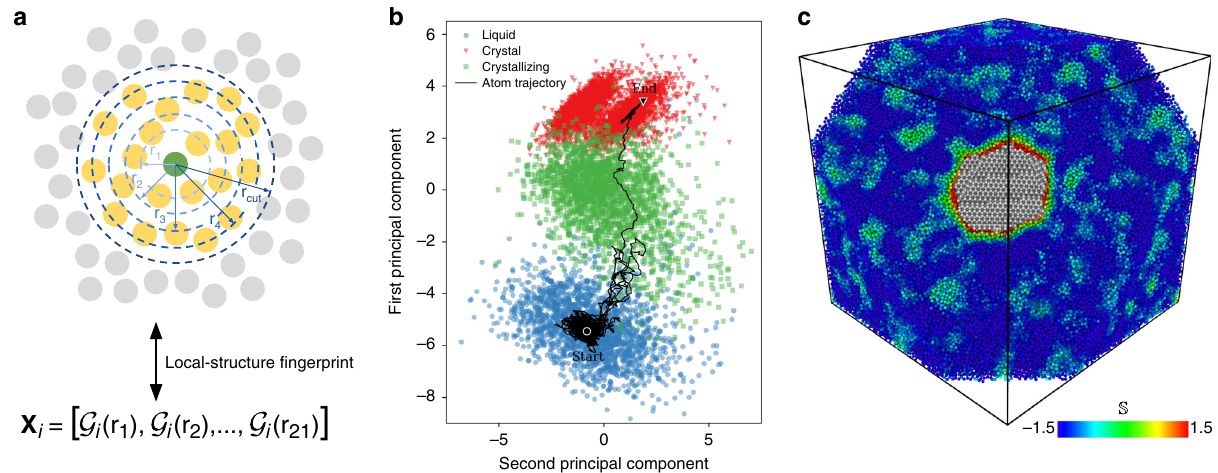
Fig. 4 Machine learning encoding of atomic crystallization events. a The local structure (atoms in yellow) surrounding a central atom (green) is encoded using a set of 21 radial structure functions Gð r n Þ , each evaluated at a different radial distance r n from the central atom, with n = 1, 2, 3, … , 21. Together these functions comprise the atom's local-structure fi ngerprint, denoted as x i for the i th atom. b Atomic trajectory during crystallization as encoded by the time- evolution of x i 2 R 21 . The R 21 -space was represented in two dimensions using the fi rst two components of the principal component analysis method. c Cross section of a snapshot of the initial stages of silicon growth. Liquid atoms are colored according to their softness ( S ) value, while atoms in the crystalline phase are colored in gray. The clusters of liquid atoms far from the crystallite with S (cid:5) 0 are due to dynamical heterogeneities in the supercooled